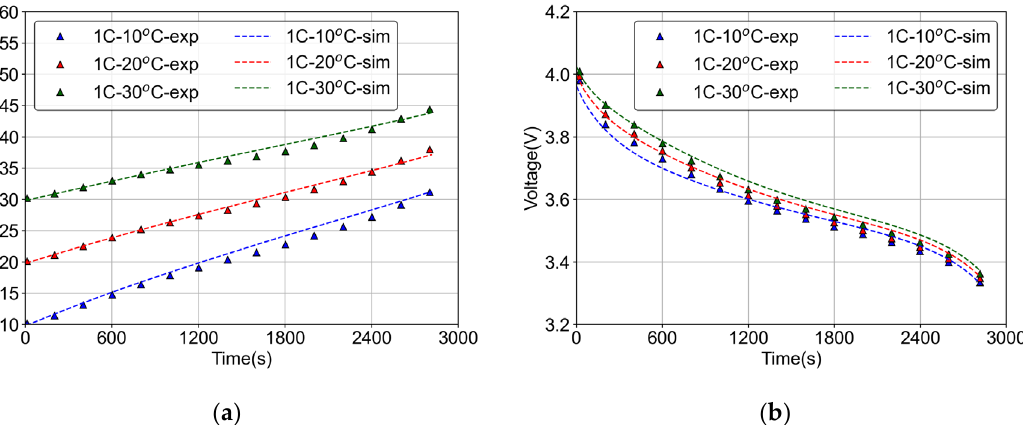
Figure 10. The verification of battery pack at different ambient temperature with 1C discharge rate: ( a ) temperature increase, ( b ) terminal voltage.